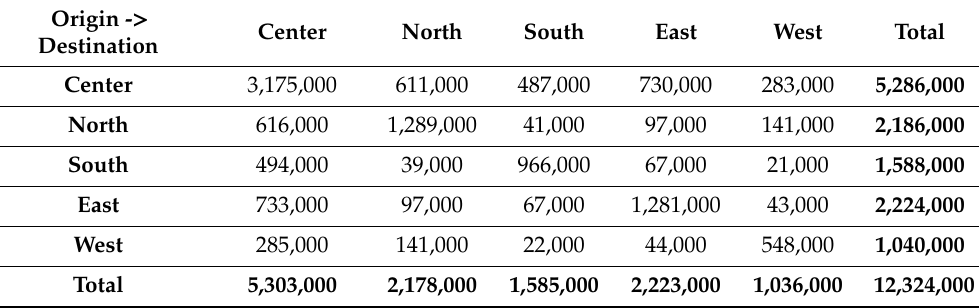
Figure 18. Trip purposes in Lima. Source: Reference [69]. Translation by authors, 2018. Central Lima contains the highest densities of employees, especially in the Miraflores business area and San Isidro CBD. JICA’s report from 2004 and collected by the PLAM 2035 [13] showed that most destinations of motorized trips were in Central Lima (Table 5 [13]). This can also be seen in the desire lines of travel (Figure 19 [39]), which are directed towards Central Lima, especially in the axis formed by the districts of Lima Cercado, San Isidro and Miraflores, having a length of around 7 km (within a city with an extension over 80 km) [65]. This means that a significant proportion of these trips would be under 7 km and could be comfortably made by bike if bicycling could be made safe and attractive and a culture of cycling developed. Table 5. Number of daily trips in motorized modes between the Four Limas and Callao.